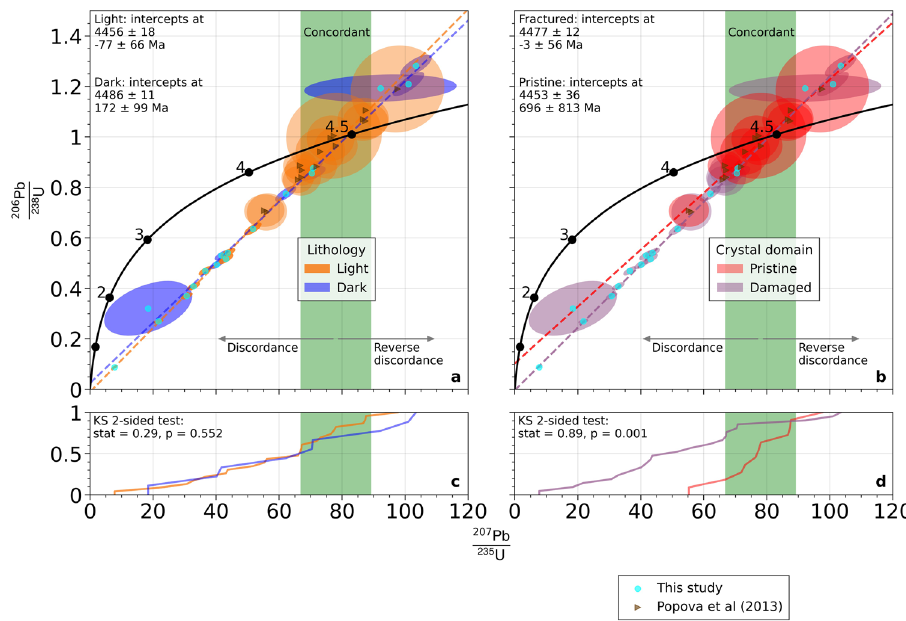
Fig. 4 Statistics and concordia chronology of phosphates in Chelyabinsk. Each data point is shown with shaded 1 σ error ellipse. a Comparison of light and dark lithology phosphate grain populations. b Comparison of pristine and damaged phosphate crystal domain analyses. c Statistical comparison of Cumulative Distribution Function (CDF) plots of 207 Pb ratios for light and dark lithology phosphate data. The populations cannot be statistically resolved 235 U using two-sided Kolmogorov-Smirnov tests. d Statistical comparison of CDFs for pristine and damaged phosphate crystal domain data. The populations are statistically resolved, with the pristine population having higher Pb/U than the damaged grain population. Regression using all data best constrains upper (4473 ± 11 Ma) and lower intercept ( − 9 ± 55 Ma